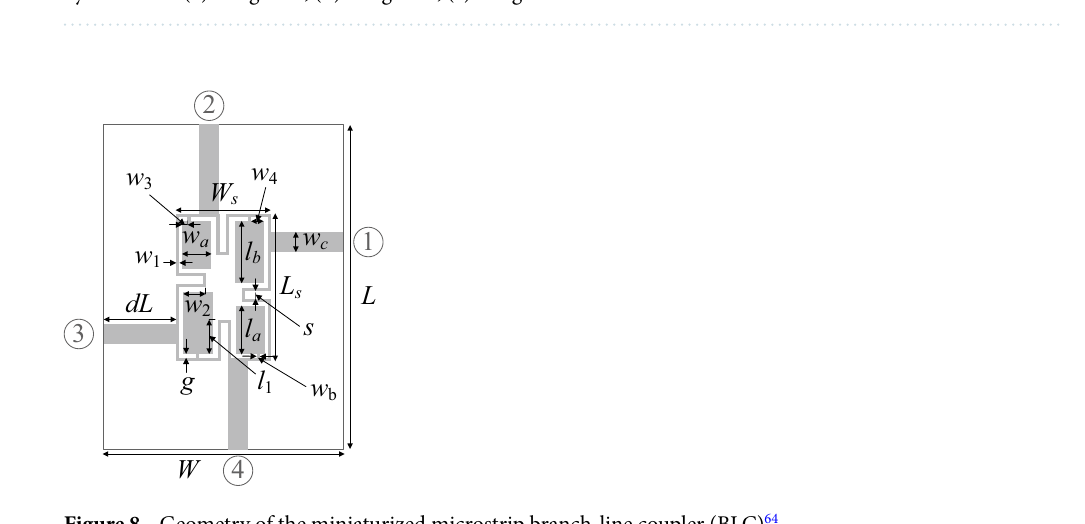
Figure 7. EM-based Monte Carlo analysis of the bandpass filter of Fig. 5 at some trade-off points from Table 1. The circuit output at the selected trade-off design is marked black, whereas 500 random trial points rendered following the probability distribution of the variance σ = F r are shown using grey color. The specs are indicated by thin lines: ( a ) design x (2) , ( b ) design x (4) , ( c ) design x (7) .